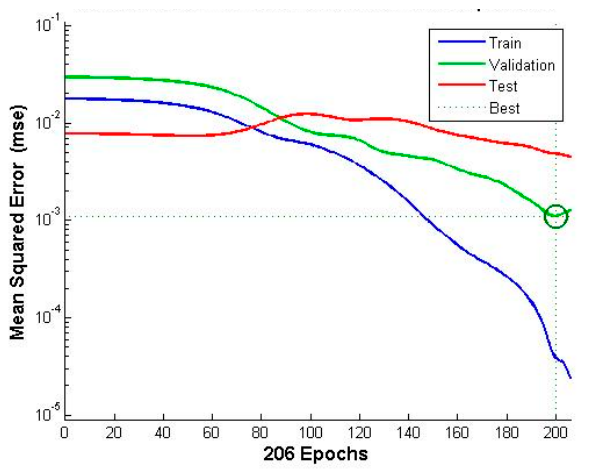
Figure 9. The error plot of the processes of model training, validation, and testing.